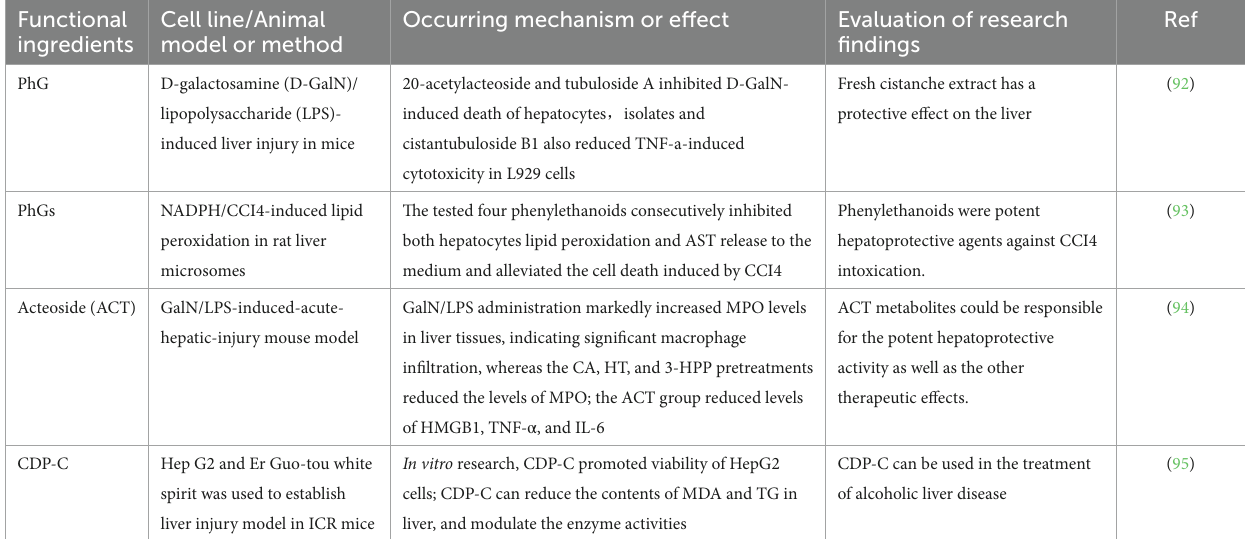
TABLE 11 Hepatoprotective effect mechanism of cistanche. Functional